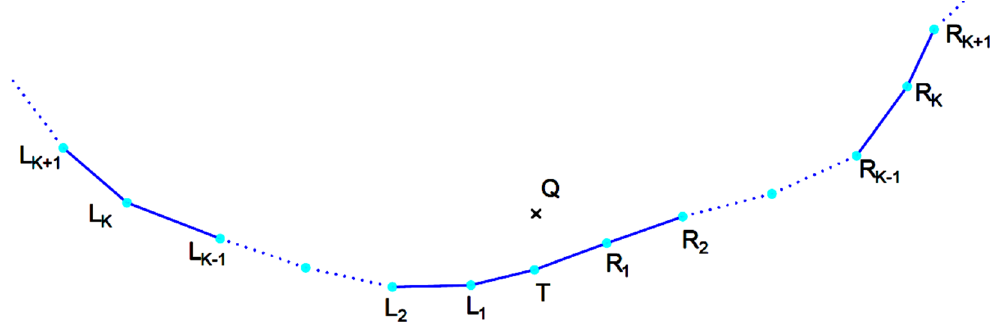
Figure 3. Finding the closest line segments to Q.